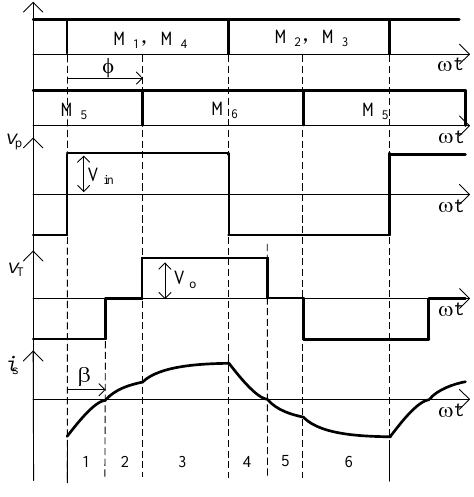
Figure 2. Steady-state waveforms of continuous current mode 1 (CCM1) operation with φ > β .